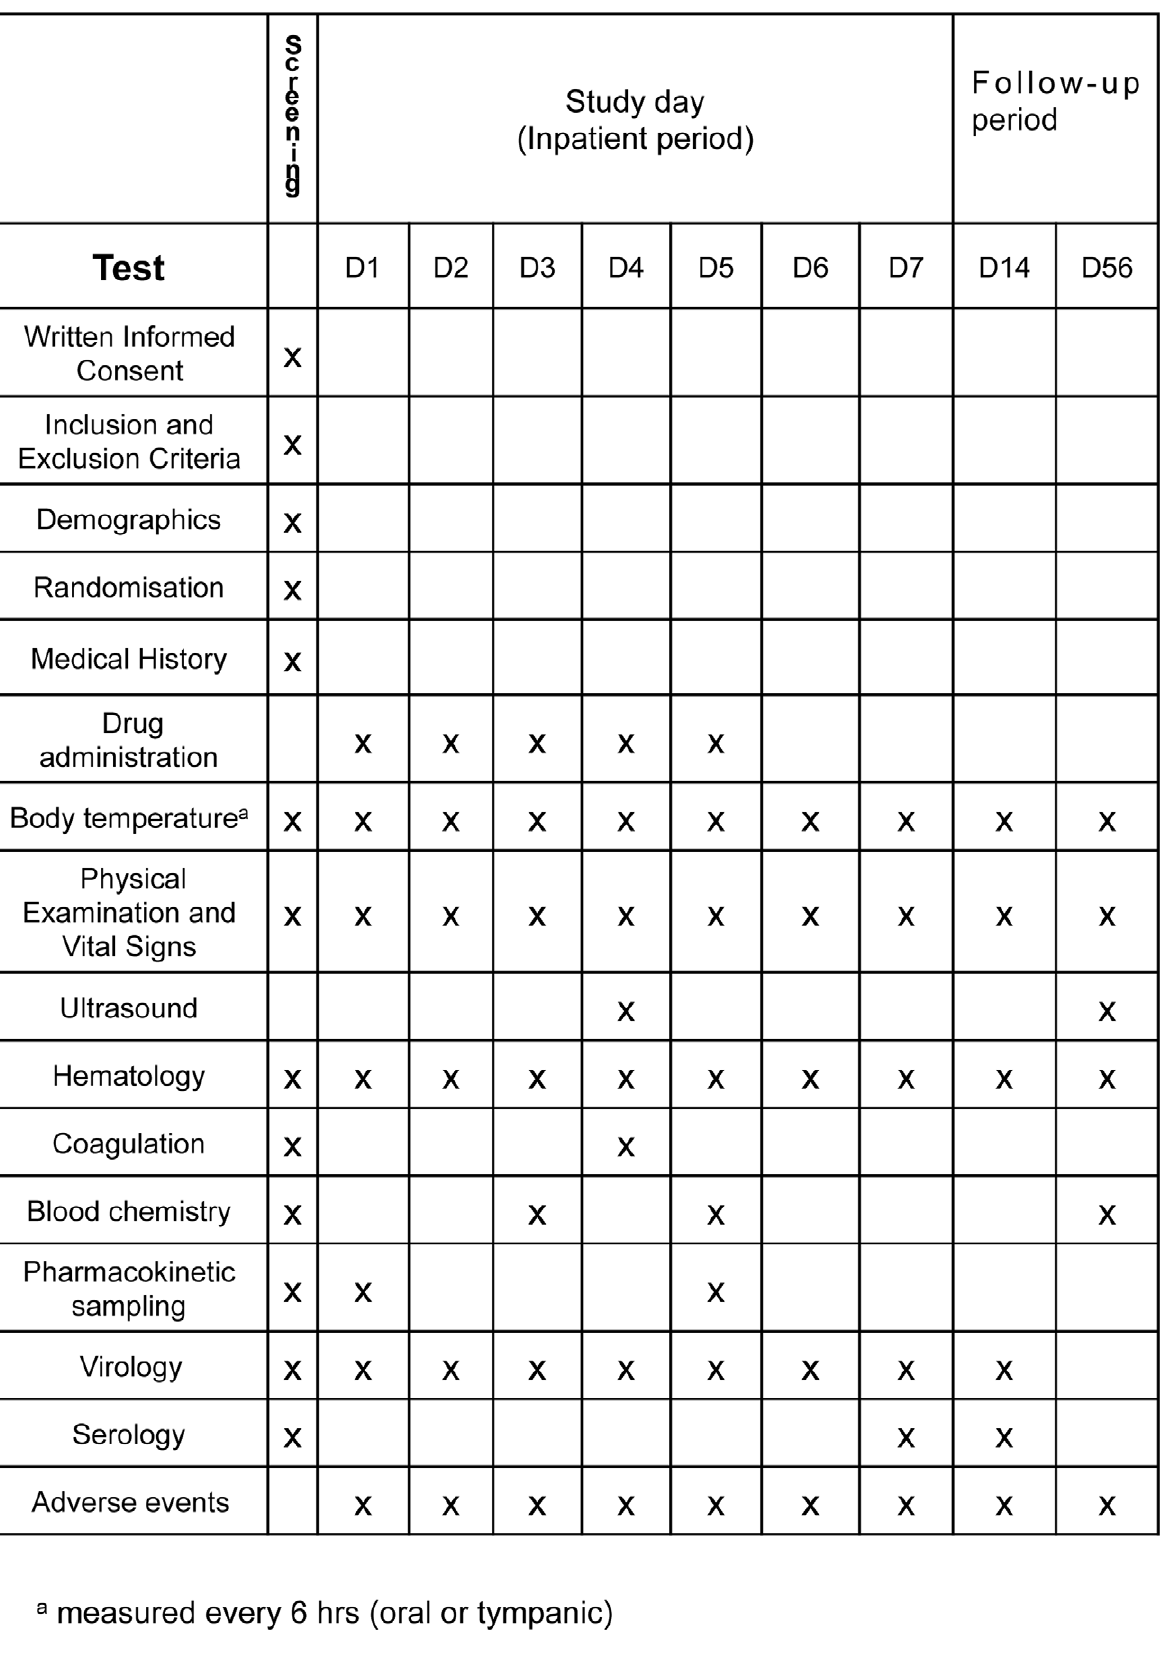
Figure 1. Suggested minimum schedule of assessments for a trial of a candidate therapeutic in a patient population with , 48 h of fever at the time of commencing treatment. doi:10.1371/journal.pntd.0001752.g001 PLOS Neglected Tropical Diseases | www.plosntds.org